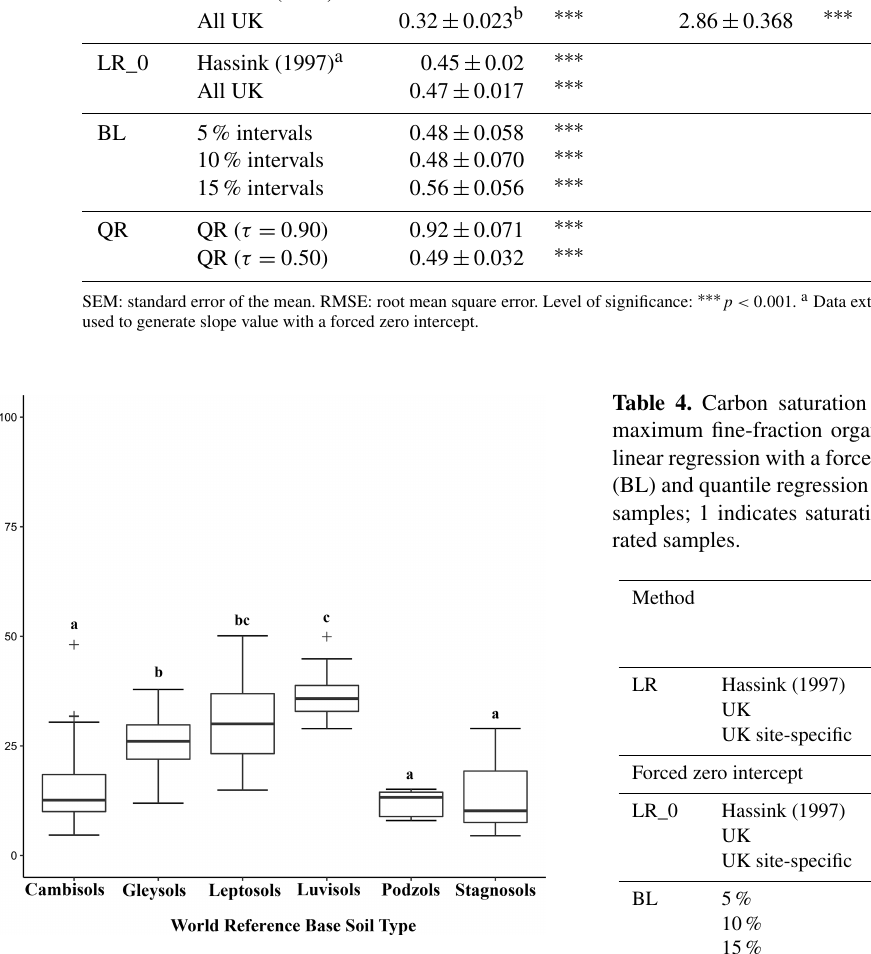
Figure 3. Relative proportion of measured fine-fraction organic car- bon of the total SOC content of the bulk soil for the different soil types used in this study. Lettering indicates significant differences at p < 0 . 05.